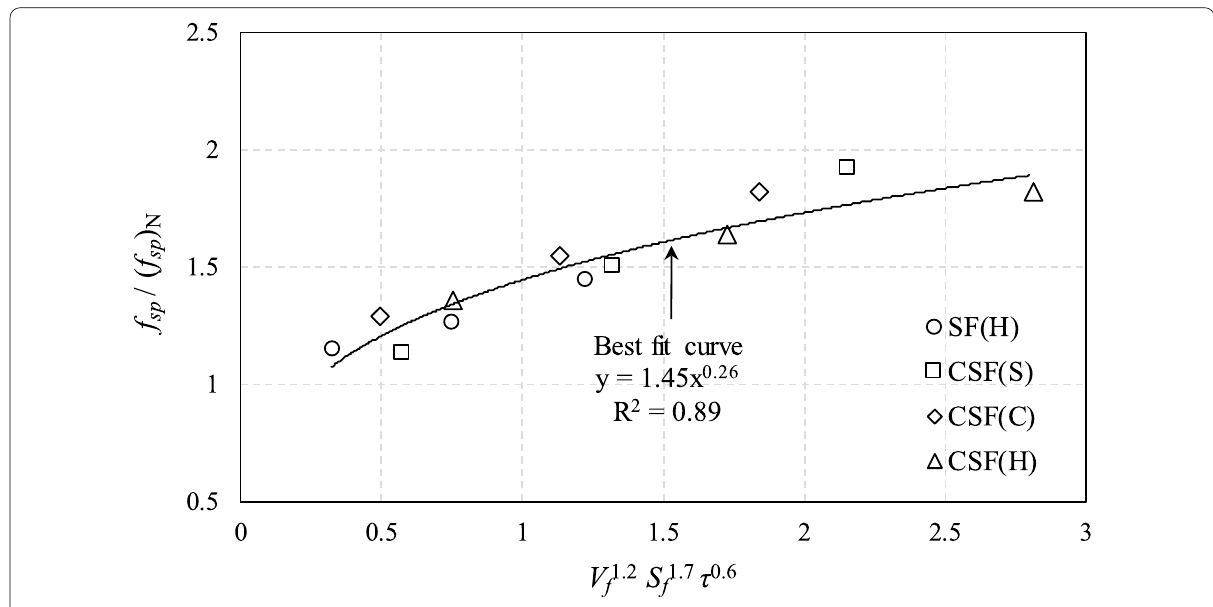
Fig. 8 Regression analysis for normalized splitting tensile strength of